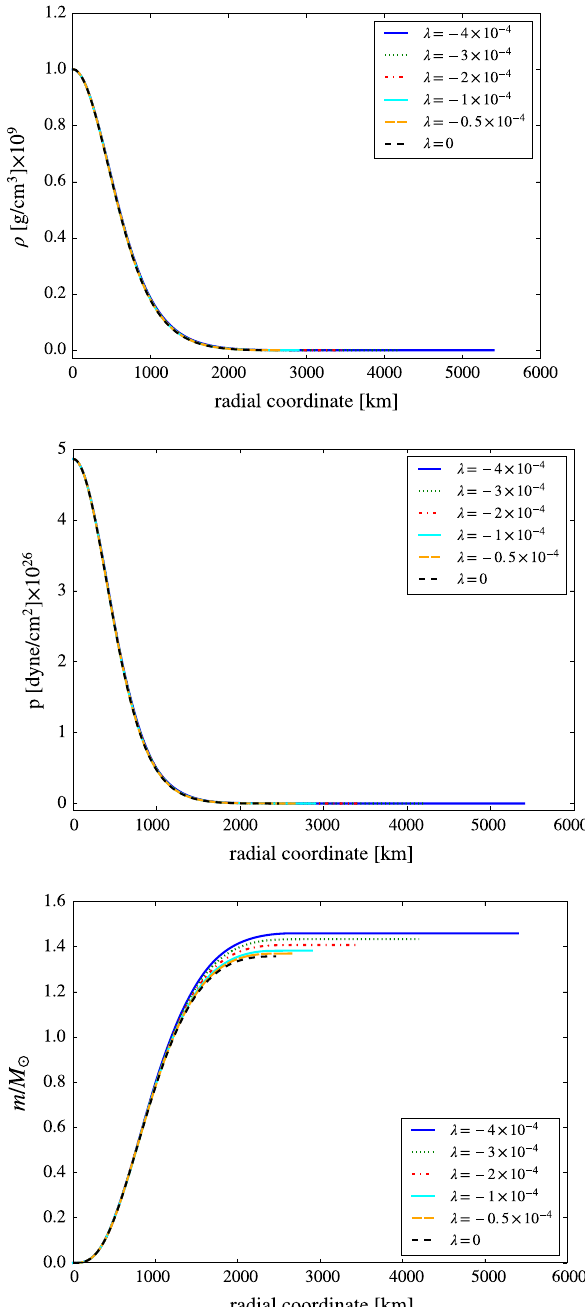
Fig. 3 On the top panel it is presented the star energy density as a function of the radial coordinate, on the central panel we show the star pressure fluid against the radial coordinate and on the bottom panel we display the mass (in solar masses, M (cid:2) ) inside the star versus the radial coordinate.Weconsider ρ c = 10 9 [ g / cm 3 ] andthedisplayedvaluesof λ